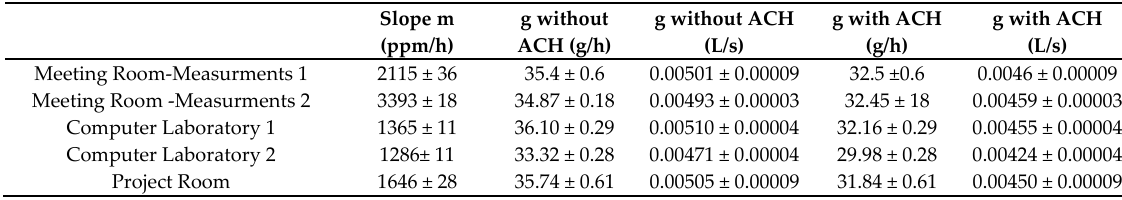
Table 2. Results of g